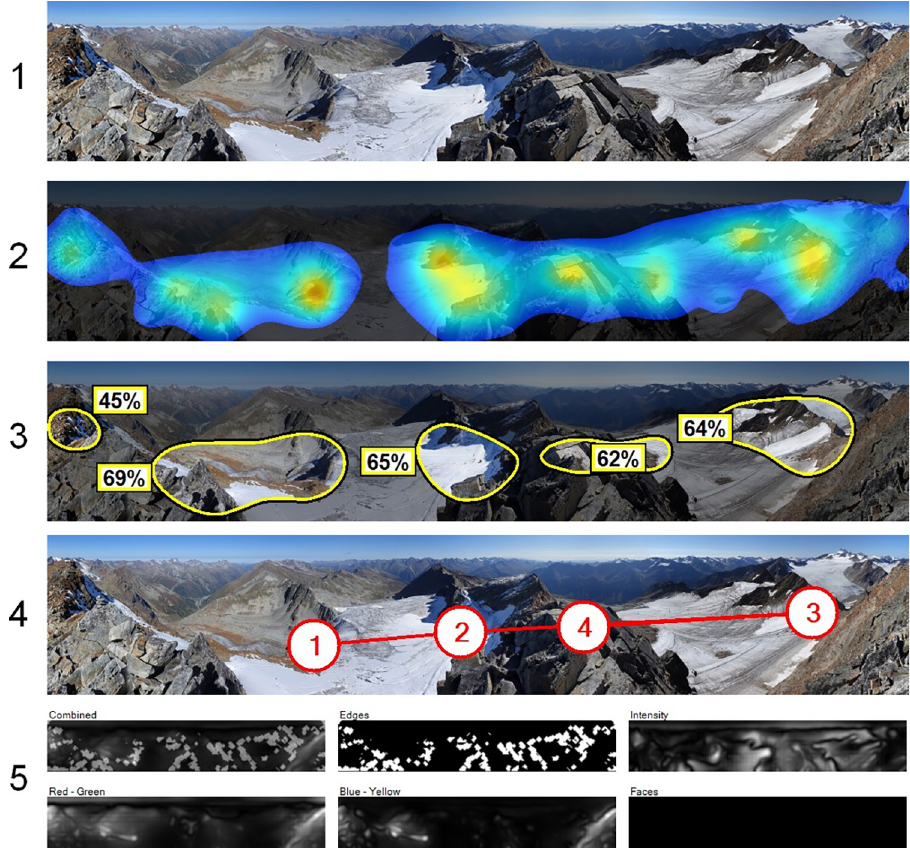
Fig 3. Output of the 3M-VAS software. (1) Original image, (2) Heatmap indicating the probability that areas are seen within the first 3–5 seconds, (3) Hotspots derived from the heatmap, specifying the probability that a person will look somewhere within the hotspot areas within the first 3–5 s), (4): Gaze sequence (most probable viewing order) of the 4 most-likely seen gaze locations, (5) Visual elements (edges, intensity, red-green color contrast, blue-yellow color contrast, faces), indicating how each of the elements contributes to the overall probability. Photograph by E